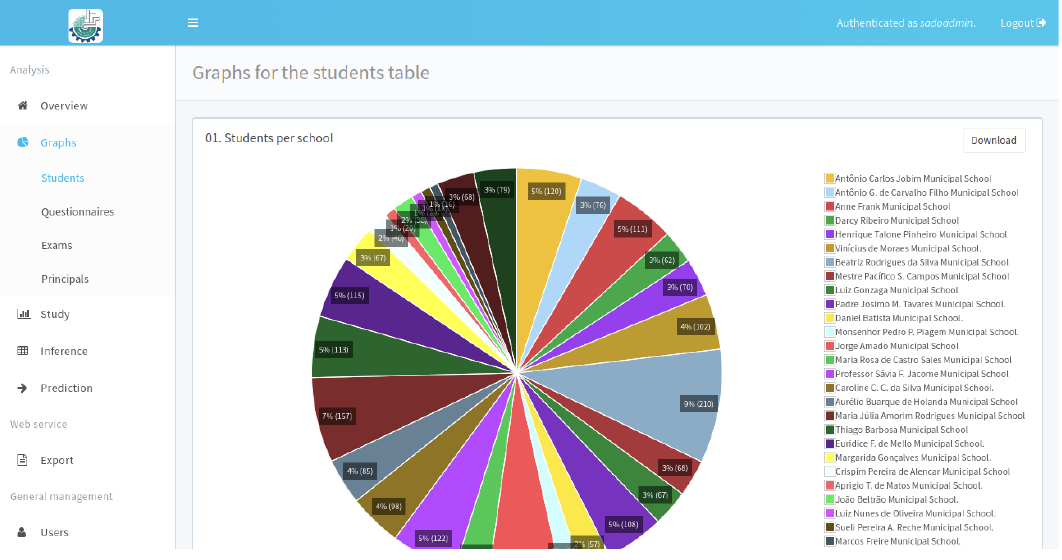
Figure 10. Graphs with the quantity of students by schools. Source: Figure elaborated by the own